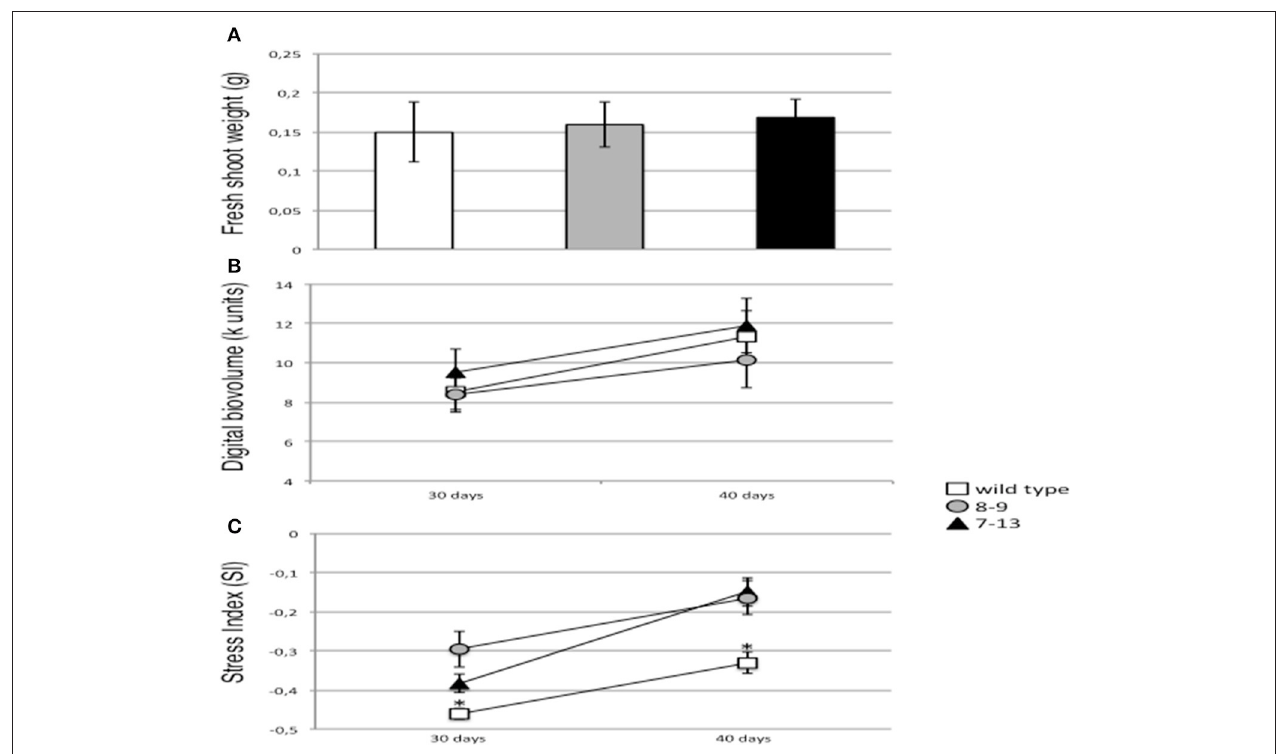
FIGURE 5 | Biomass parameters and stress index in normal watering vegetative growth conditions. (A) Shoot fresh weights of wild type (white bar), 8–9 (gray bars) and 7–13 (black bars) plants under growth chamber conditions. Data represent the mean and standard errors obtained from 3 independent experiments (10 plants per experiment). (B) Digital bio-volumes of wild type (white square), 8–9 (gray circle) and 7–13 (black triangle) plants under greenhouse conditions. The measures refer to the sum of the projected areas (in pixels) of the plant leaves from the two orthogonal side views and the natural logarithm of one third of the projected plant area from the top view. Data points represent the mean and standard errors obtained from three plant replicates. (C) Stress index of wild type (white square), 8–9 (gray circle) and 7–13 (black triangle) plants under greenhouse conditions. Data points represent the mean and standard errors obtained from six images (two images per plant). Florescence re-emission has been measured with a Scanalyzer 3D platform (LemnaTec). Asterisk indicates significant differences between wild type and transgenic plants ( p < 0.0001; VassarStats analysis of variance